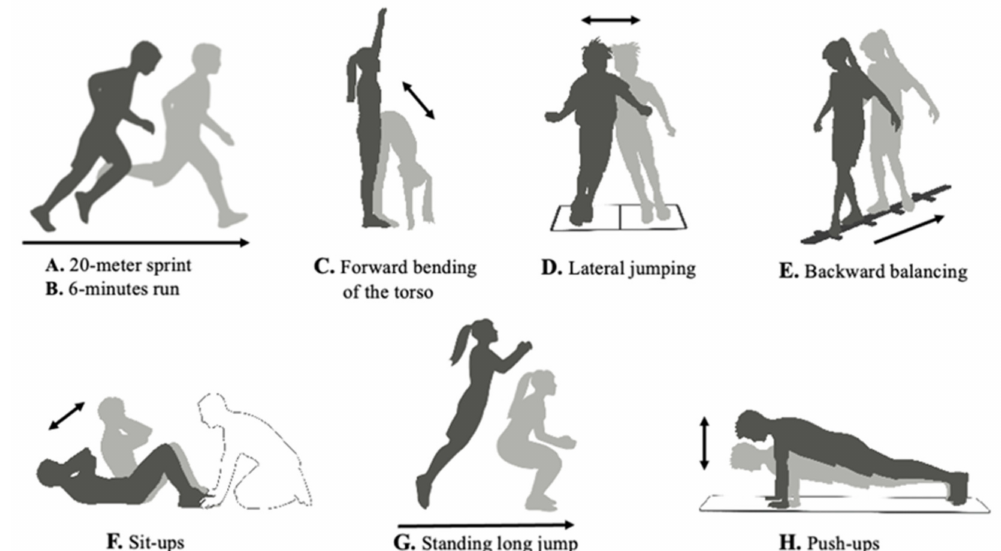
Figure 1. Physical fitness tests via the German Motor Test 6–18 (DMT 6–18). Performance: ( A ) Speed via 20-m sprint; ( B ) Endurance via 6-min run; ( C ) Flexibility via forward bending; ( D ) Coordination of the jumping; ( E ) Coordination of the backward balancing; ( F ) Strength of the abdominal muscles via sit-ups; ( G ) Strength of the lower extremities via jumping ability; ( H ) Strength of the upper extremities via push-ups; DMT, Deutscher